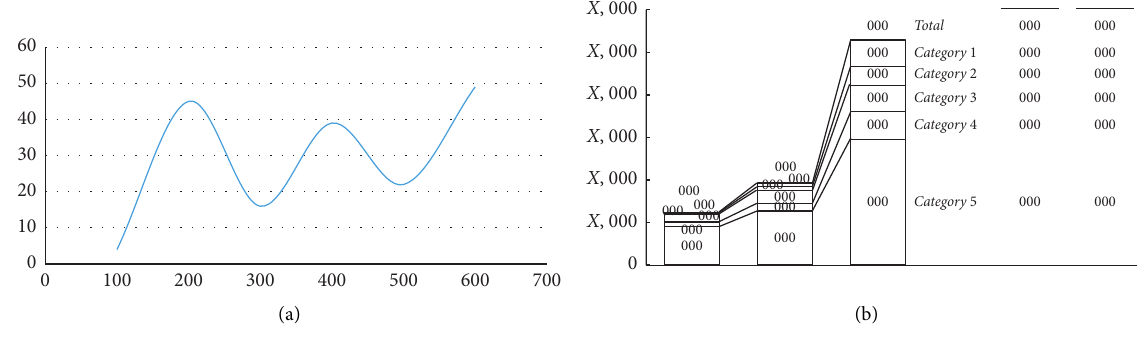
Figure 7: The matching effect of trajectory